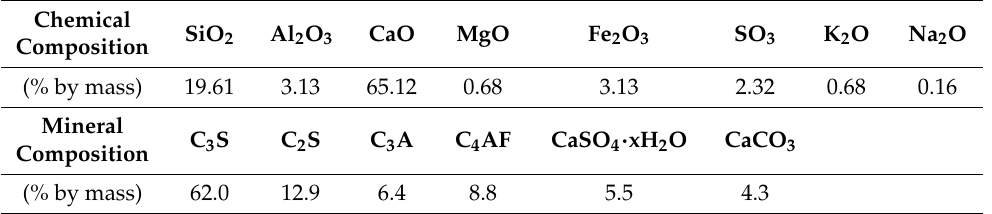
Table 1. Chemical analysis and mineral composition of cement.